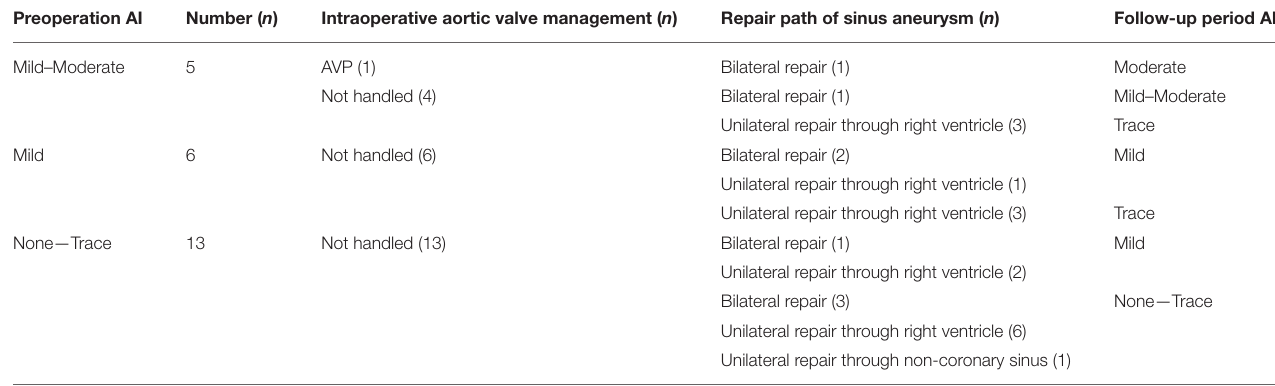
TABLE 4 | Conditions of patients with unruptured sinus of Valsalva aneurysms (USVA) accompanied by AI (regurgitation classed as moderate or worse preoperatively). Preoperation